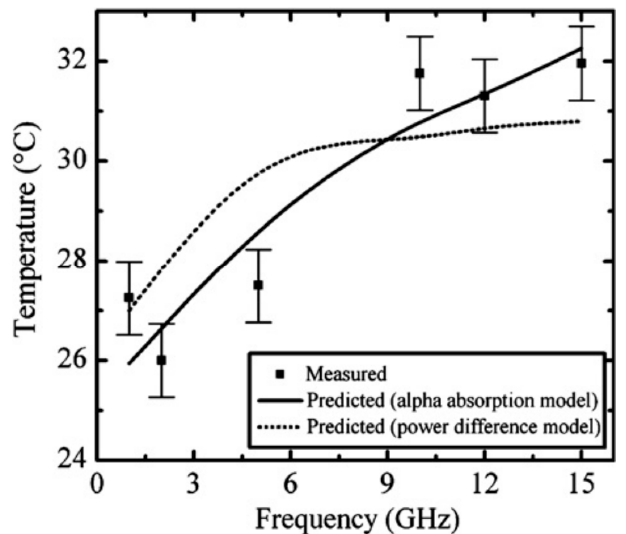
Figure 3. The temperature changes in the microchannel in the CPW-based module, with comparison to the predicted ones [81]. Reprinted from Shah, J.J.; Sundaresan, S.G.; Geist, J.; Reyes, D.R.; Booth, J.C.; Rao, M.V.; Gaitan, M. Microwave dielectric heating of fluids in an integrated